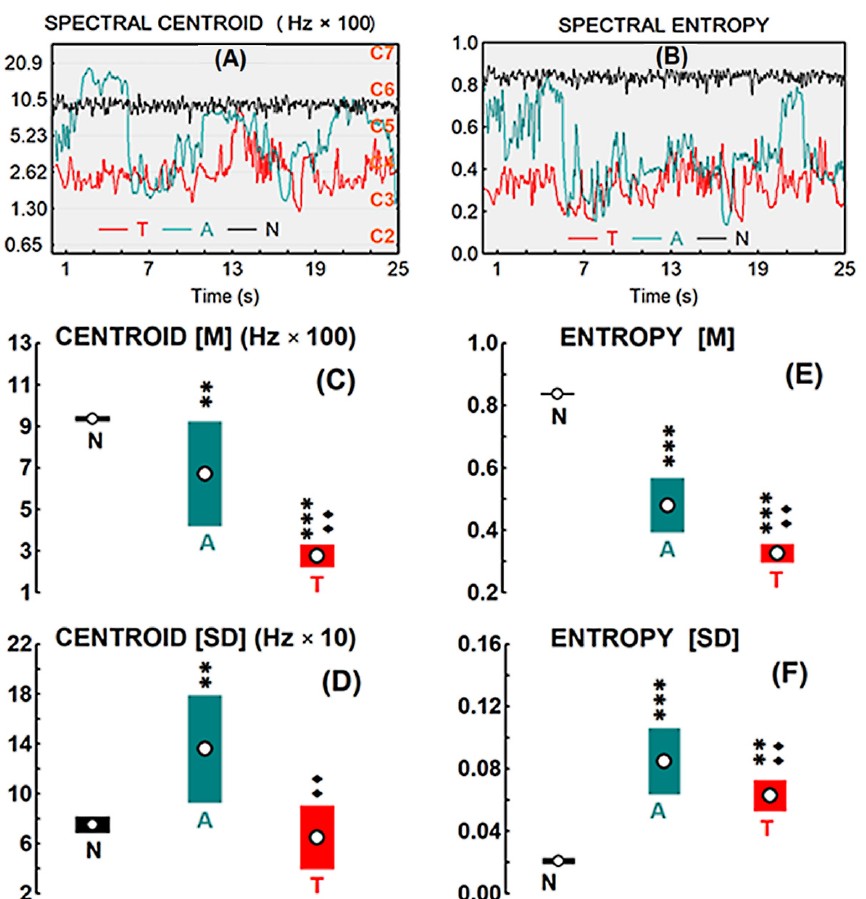
Figure 2. ( A ) Time evolution of the spectral centroid of each signal-stimulus [N for noise, A for atonal, T for tonal]; the frequency of the different octaves (C2 to C7 on the right) is indicated on the left. ( B ) Time evolution of spectral entropy. ( C ) Spectral centroid mean [M] and ( D ) Spectral centroid variability [SD] throughout the stimulus time. ( E ) Spectral entropy mean [M] and ( F ) Spectral entropy variability [SD] throughout the stimulus time. Open circles indicate the means, and color ranges the 95% confidence interval. Statistical significance levels of the differences between T or A against N were indicated by asterisks: (**) when p < 0.01, and (***) when p < 0.001. The same levels, but in solid diamonds ( (cid:7) ), were used for T against